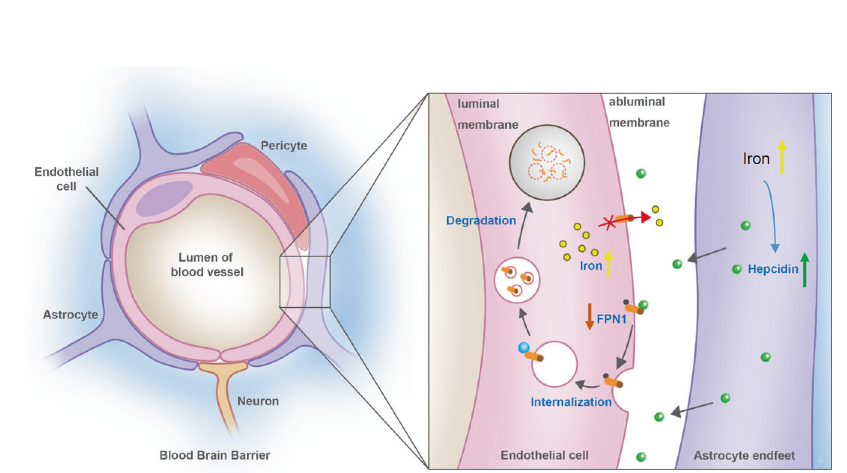
Fig. 7 The working model of iron transport across BBB and underlying regulation. Endothelial cells and the surrounding astrocytes are two major components of BBB, where hepcidin and FPN1 are two key molecules in controlling iron transport across BBB into brain parenchymal tissues. In response to the elevated brain iron level, more hepcidin in the astrocyte secreted through its endfeet to directly decrease FPN1 level of BMVECs, which decreased the iron in fl ux from blood into brain tissues and therefore kept the iron